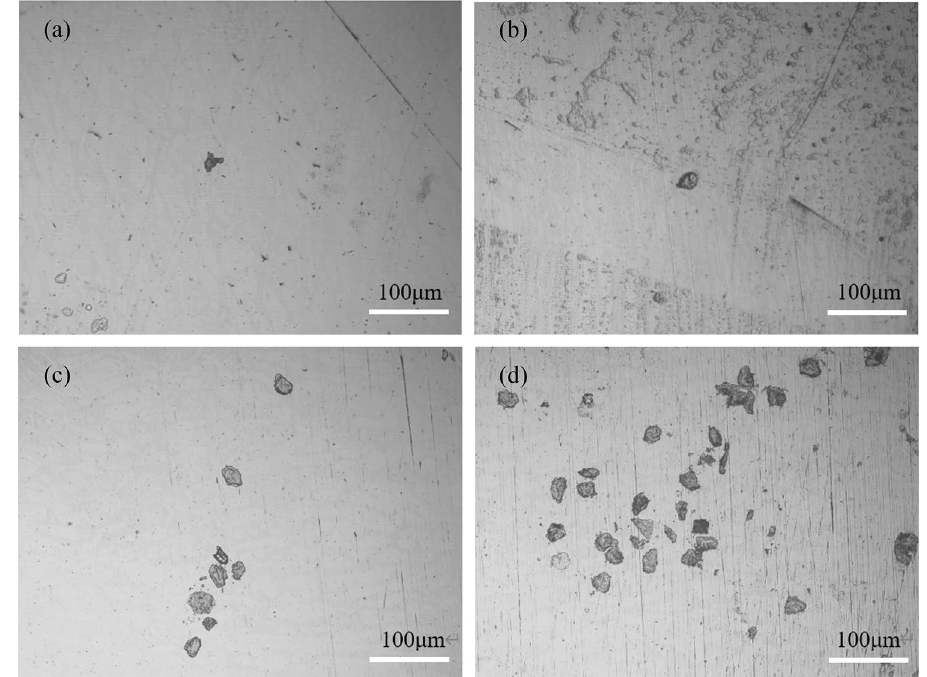
Figure 9. Corrosion profile of 2205 DSS in simulated solution containing 100 g/L Cl − and saturated CO 2